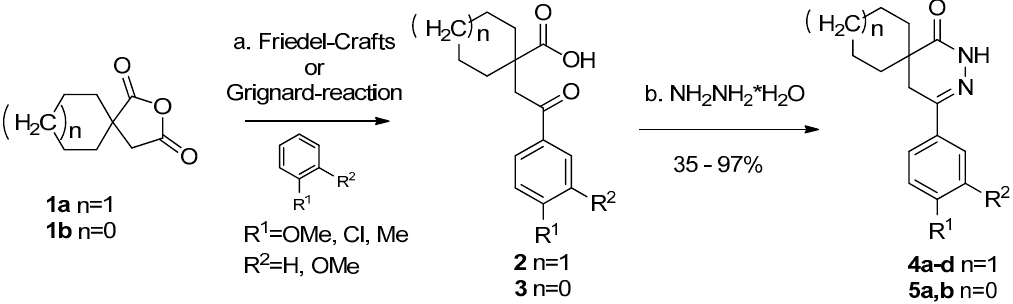
Figure 1. Pyridazine derivatives under clinical development: ensartinib, relugolix, talazoparib, and olaparib.